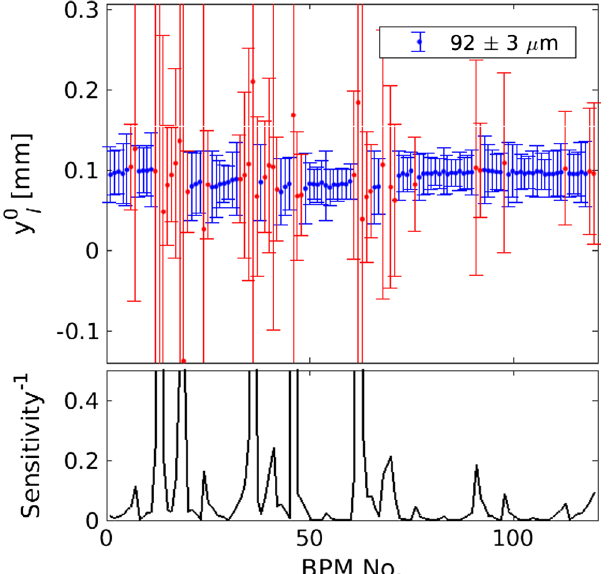
FIG. 3. The upper plot shows the BPM l estimated offsets obtained from the lines intersection using data from all the other 119 BPMs. The cases where the error bar is larger than three times the average error bar are highlighted in red and removed from the final average. The lower plot shows the inverse of the difference between the slopes in Eqs. (2) and (3) estimated from the model. Notice that the removed BPMs (red dots) in the upper plot coincide with those for which the such sensitivity factor is close to zero (the inverse factor has a peak) in the lower plot. The data shown here corresponds to the case BPM l ¼ 69